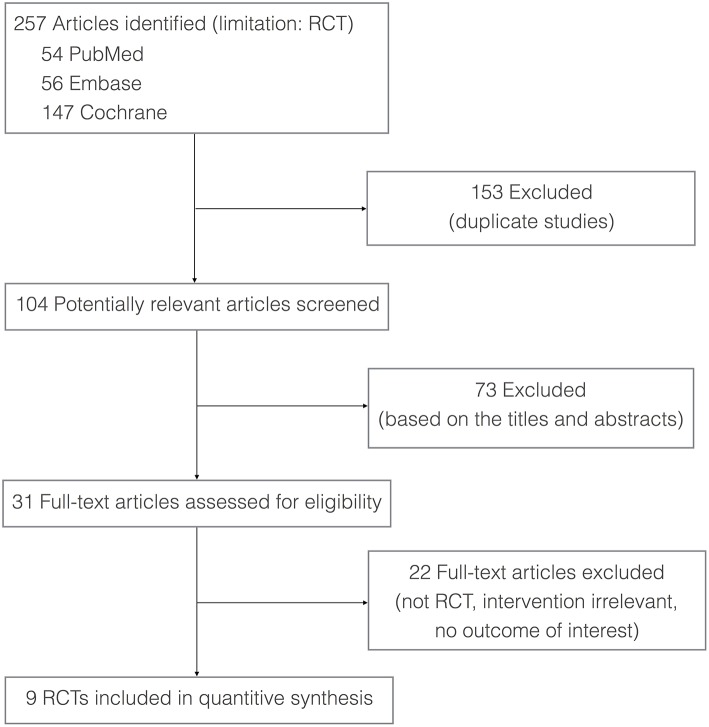
Flow diagram of the process for identification of the included studies.